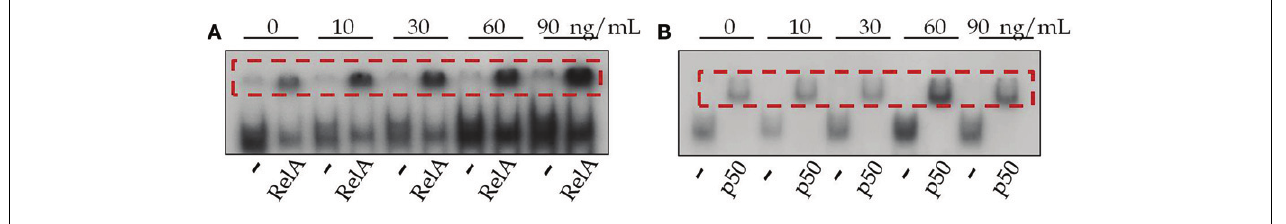
FIGURE 7 | Effects ofTNF on the translocation of NFKB subunits to the nucleus. (A) Representative gel of anti-RelA-supershifted NFKB in glands stimulated or not stimulated withTNF